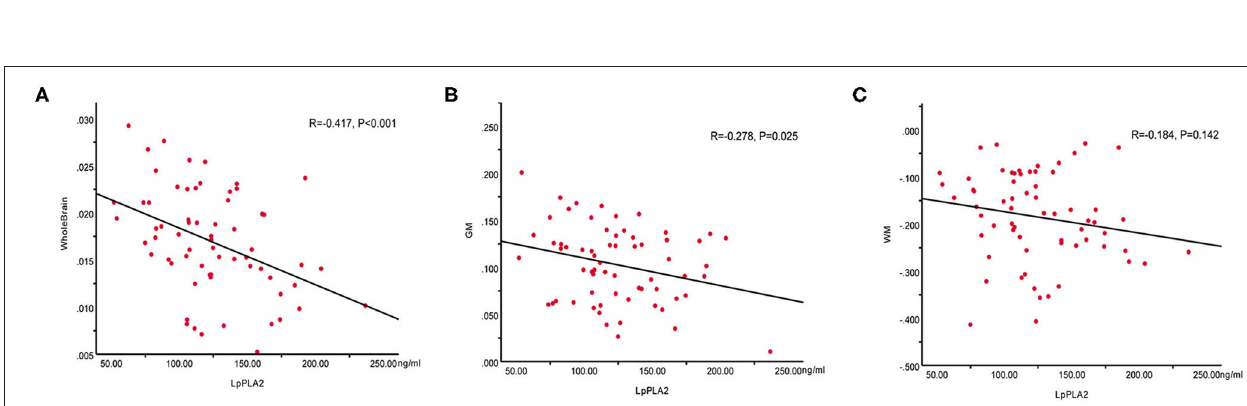
Frontiers in Neurology | www.frontiersin.org 5 January 2022 | Volume 12 | Article